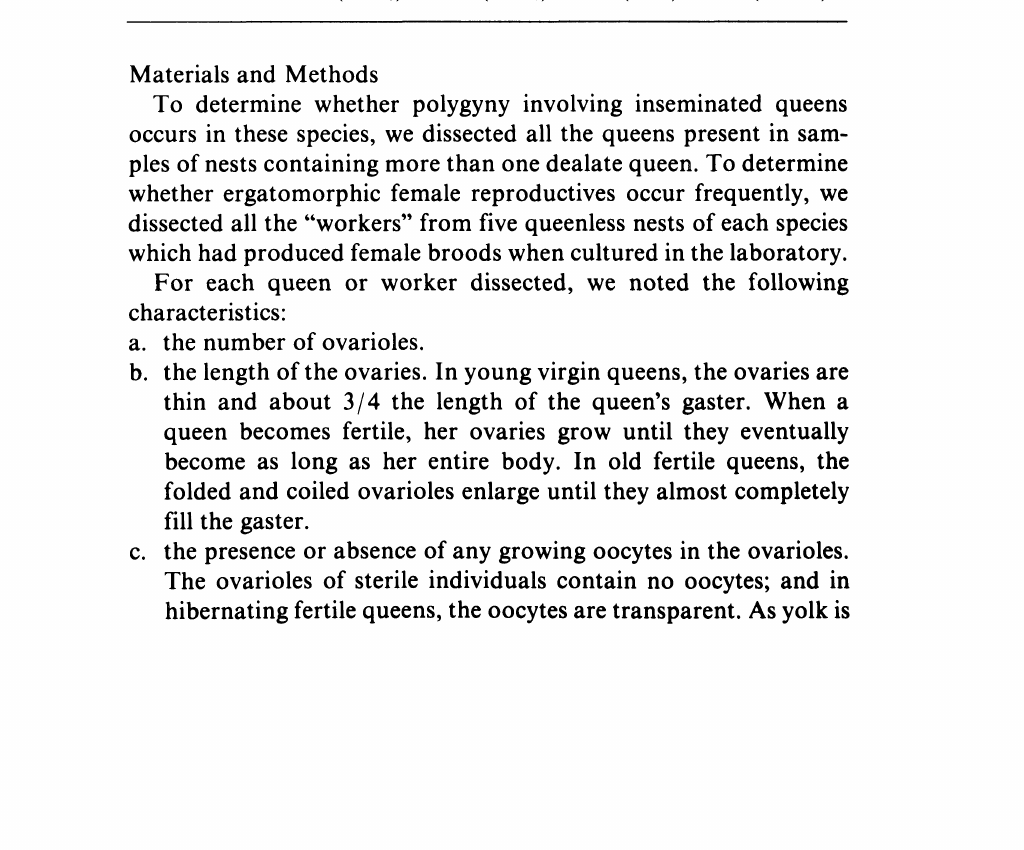
Table 2. Number and Percent of Queenright and Queenless Nests of L. ambiguus, L. curvispinosus, and L. longispinousus Containing Pupae and/or Alate Reproductives of Various Types at the Time of Collection (1977-78) Queenright Nests ? and or ? and or Species Only and Only Total L.